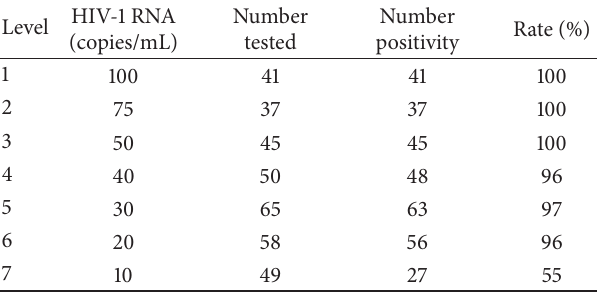
Table 1: Lower limit of detection of the HIV-1 RNA-based Amplix real-time PCR assay using the 3rd WHO HIV-1 subtype B inter- national standard (National Institute for Biological Standards